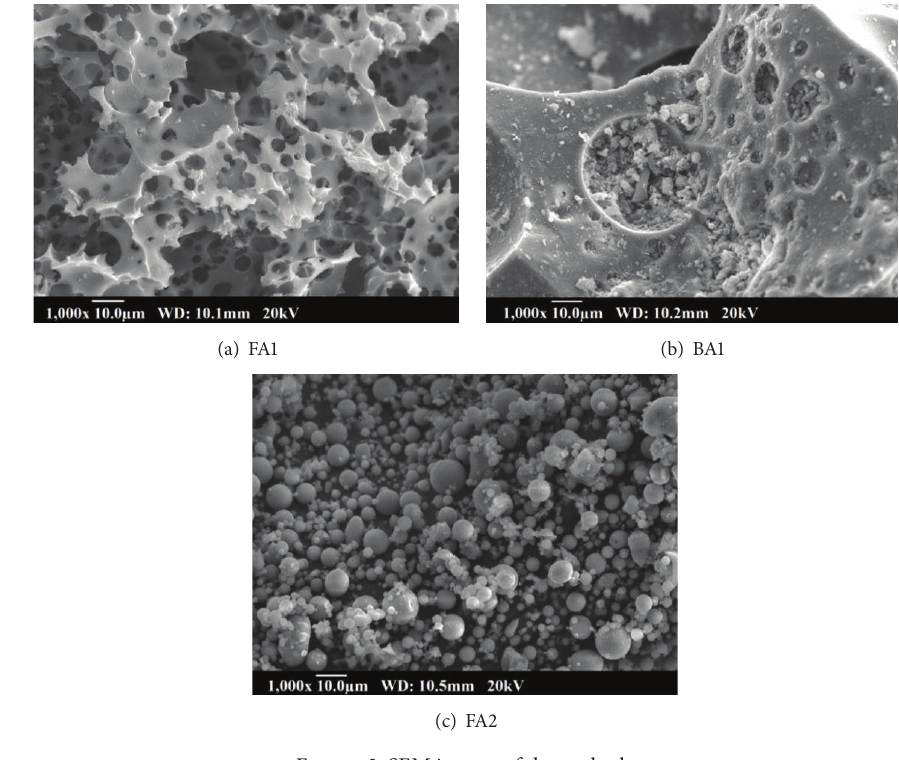
Figure 3: SEM images of the coal ash.